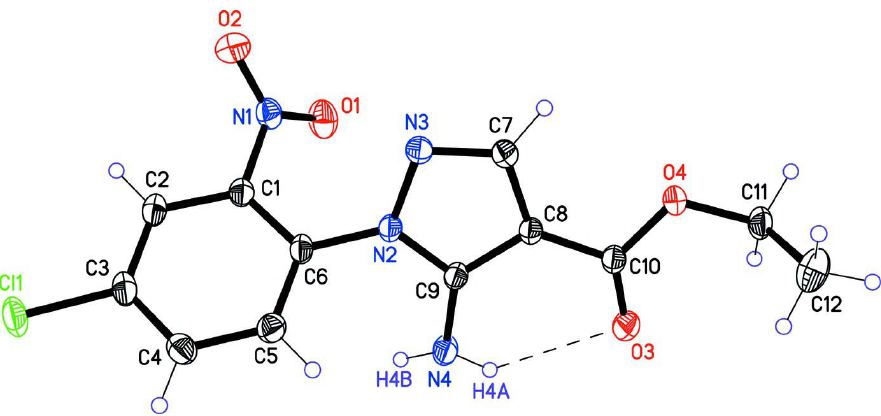
The asymmetric unit of the title compound highlighting the intramolecular H-bond. Displacement ellipsoids are drawn at the 50% probability